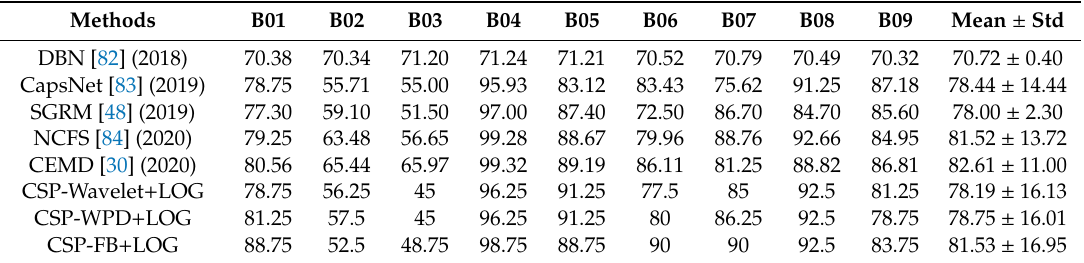
Table12. ClassificationaccuracyoftheproposedmethodsandotherresentmethodsforBCICompetition IV Dataset